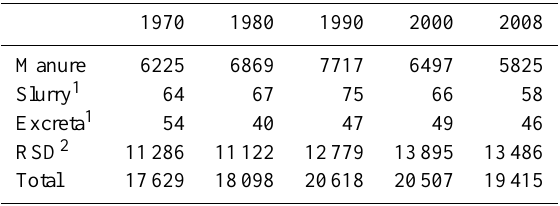
Table 2. Amount of organic carbon from different sources applied to soils in agricultural lands of Japan, employed in simulation (unit: GgCyr − 1 ) .